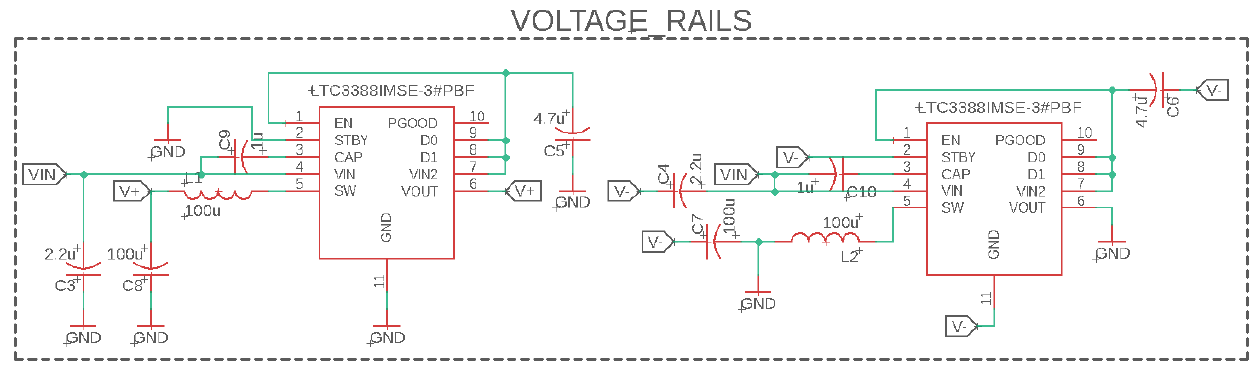
Figure 11. Voltage rail circuit used to achieve ± 5 V ( V + and V − ) output using 5 V input, V IN .